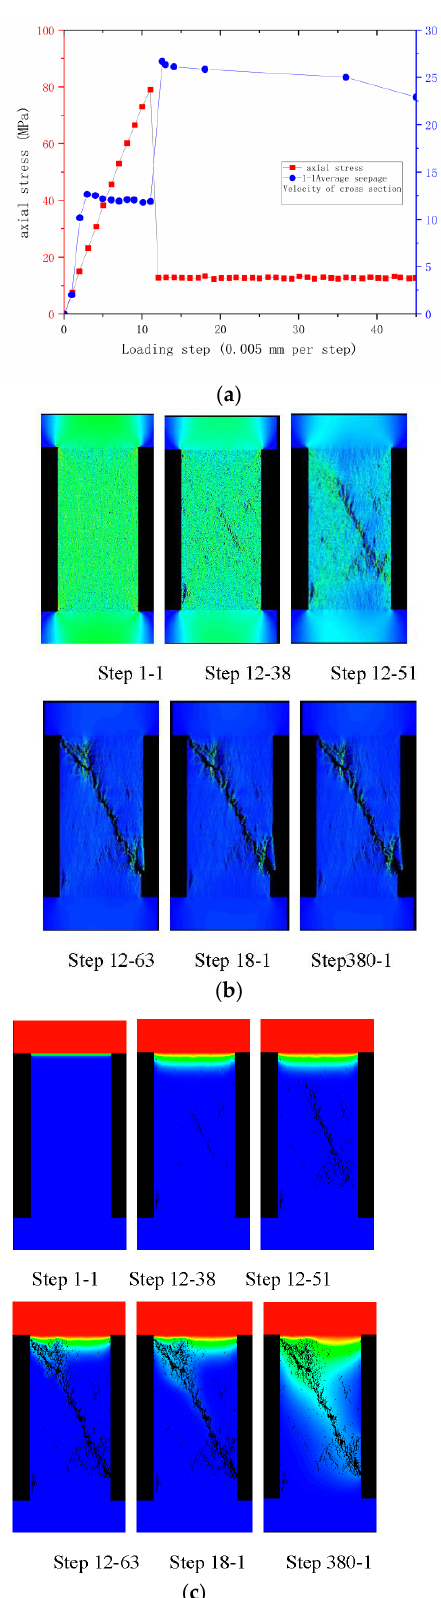
Figure 8. Numerical results for Sample 3. ( a ) Whole process curve of load step-stress-permeability coefficient. ( b ) Stress results for the intact specimen during the failure process (MPa). ( c ) Results of water pressure distribution during crack formation (m).